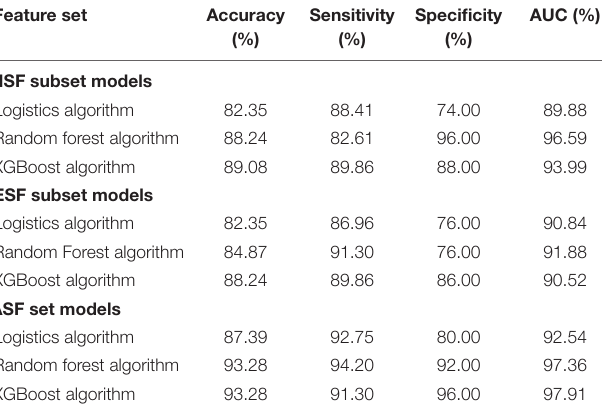
TABLE 4 | Classification performances of combined